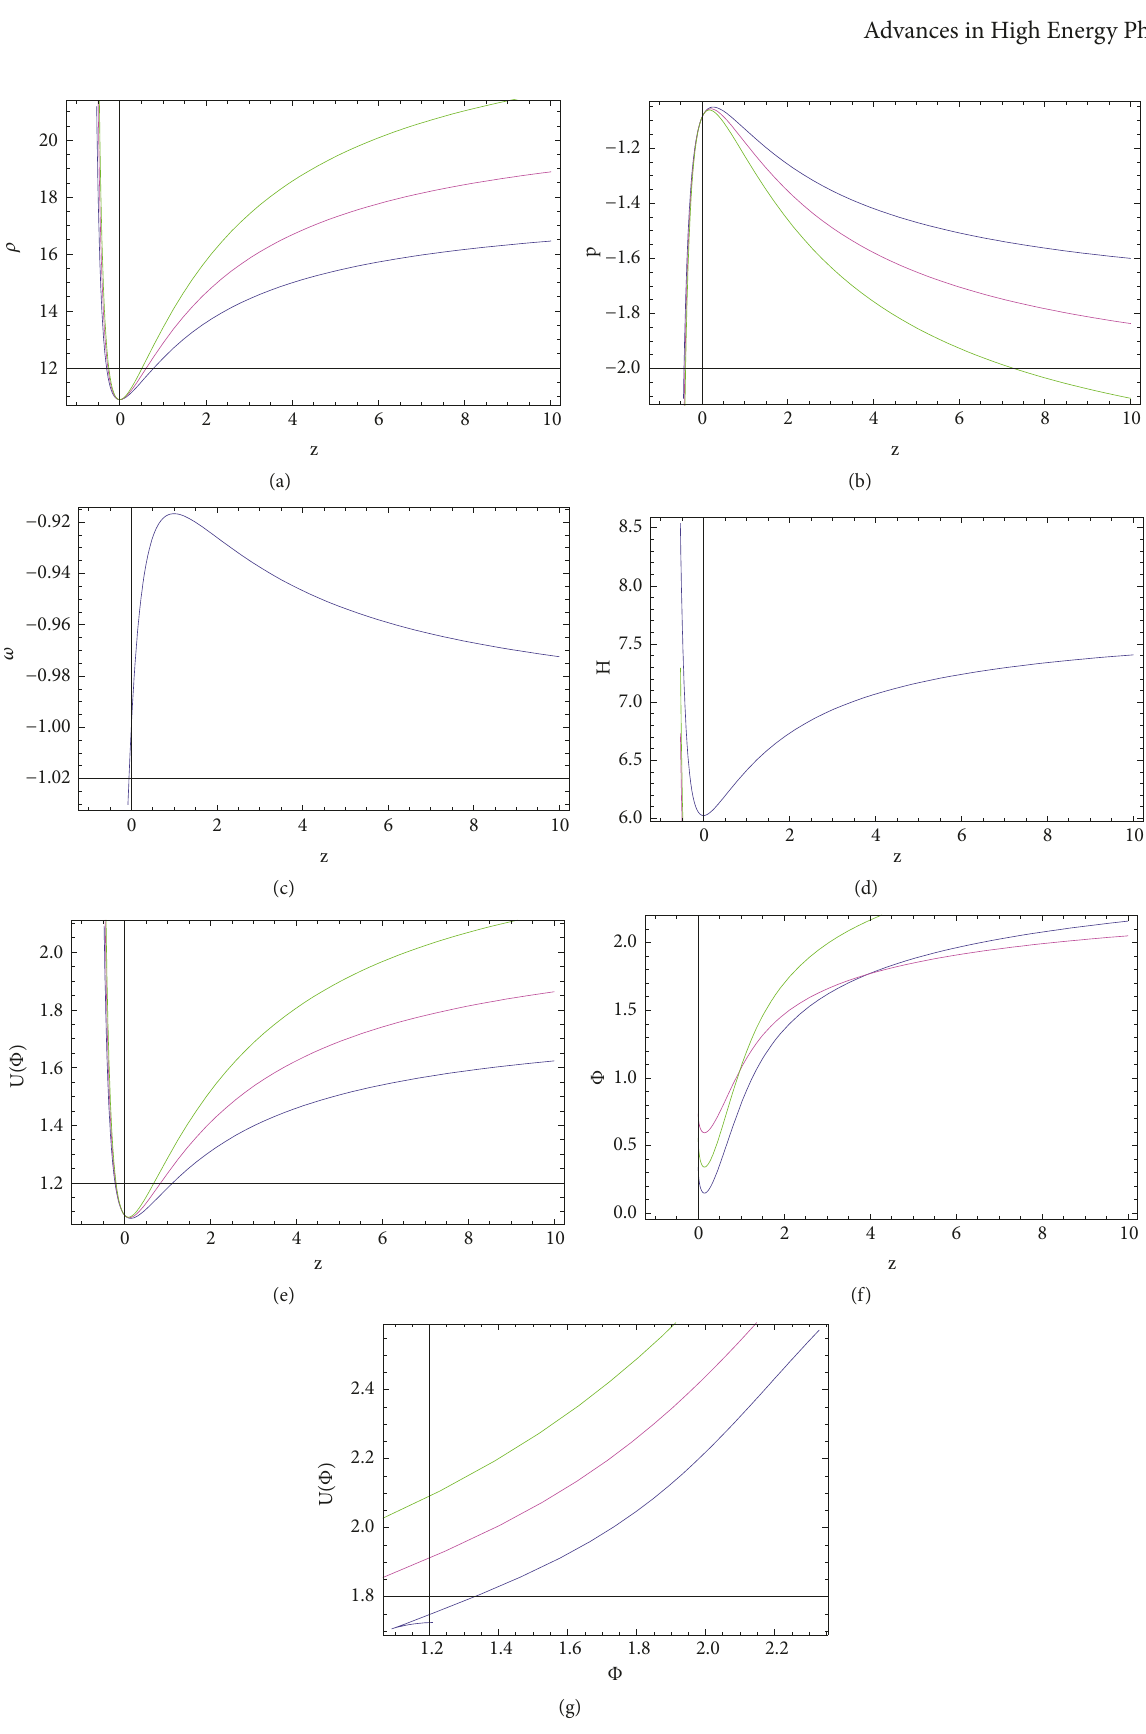
Figure 3: (a), (b), (c), (d), (e), and (f) show the variation of energy density 𝜌 , pressure 𝑝 , EoS parameter 𝜔(𝑧) , Hubble parameter 𝐻 , potential 𝑈(𝜙) , and the scalar field 𝜙 with the variation in 𝑧 for the JBP parameterizations. (g) shows the variation of 𝑈(𝜙) with 𝜙 . Different colored paths are obtained for different values of